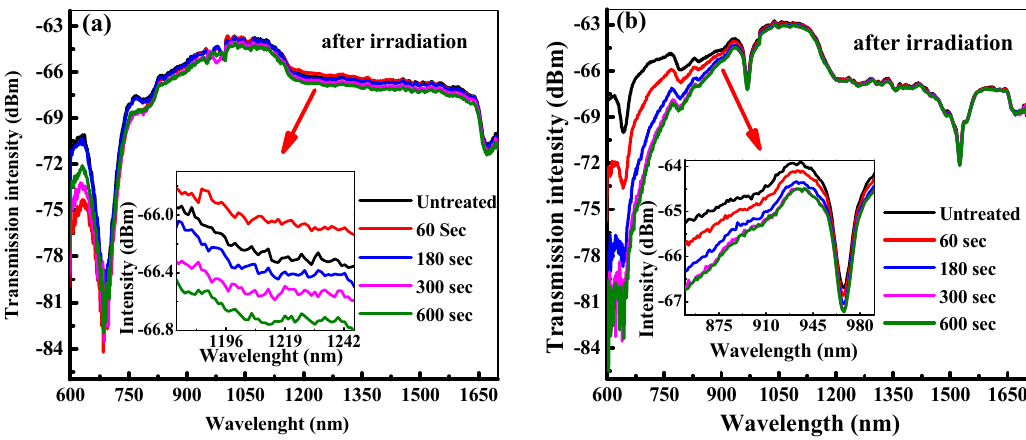
Figure 2. ( a ) Transmission spectra of Bi-doped fiber before and after irradiation as a function of time and the enlarged luminescence spectra, from 1170 nm to 1245 nm, is inserted. ( b ) Transmission spectra of Bi/Er co-doped fiber before and after irradiation, as a function of time and the enlarged luminescence spectra, from 850 nm to 1000 nm, is inserted.